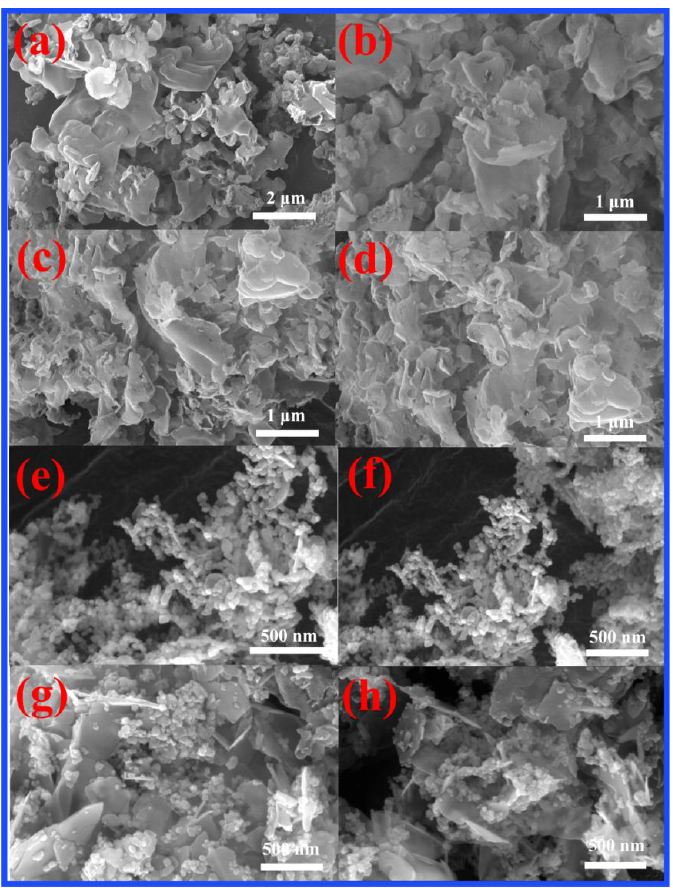
Figure 3. ( a , b ) SEM images of CN; ( c , d ) SEM images of CN-200; ( e , f ) SEM images of Z-500; ( g , h ) SEM images of CN-200/Z-500 photocatalyst.